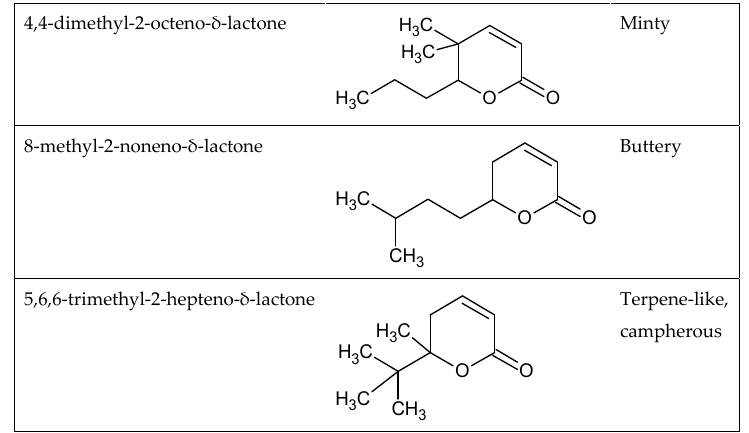
Figure 2. Examples of odorants with common functional groups and dissimilar odors [24]. Int. J. Mol. Sci. 2019 , 20 , x FOR PEER REVIEW